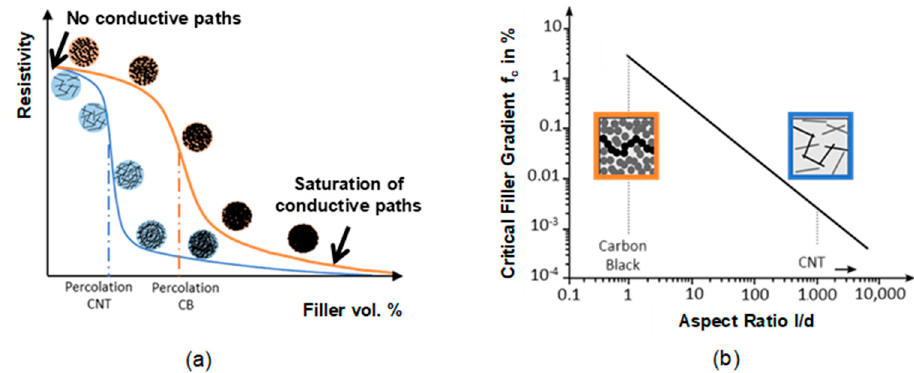
Figure 2. Influence of filler type: ( a ) composite resistivity behavior in dependence on filler volume concentration of carbon nanotubes (CNTs) and carbon black (CB), ( b ) critical filler gradient in dependence on the aspect ratio.